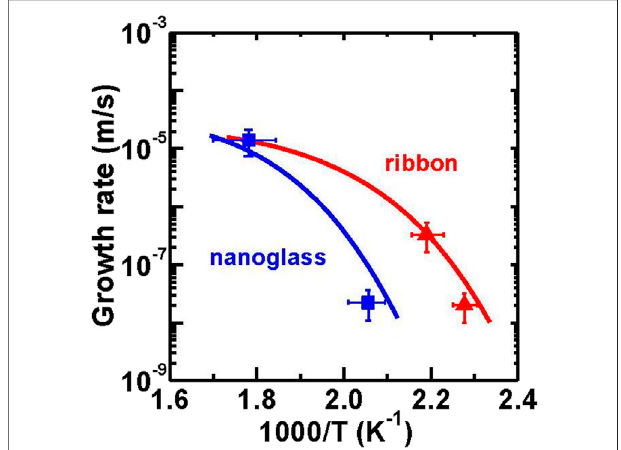
FIGURE 22 | Comparison of measured and simulated growth rate of crystals with temperature for Au52Ag5Pd2Cu25Si10Al6 nanoglass and ribbon (from (Wang J. Q. et al.,